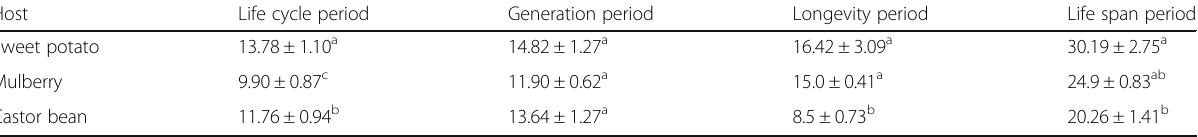
Table 2 Influence of different host plants development durations on of Tetranychu s urticae females